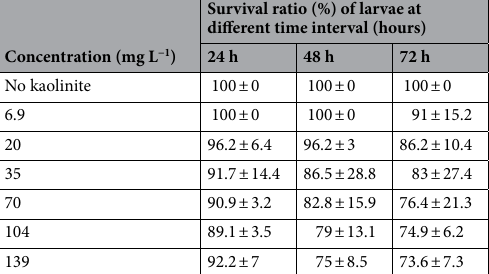
where H r and C are the relative hatching ratio and suspended particle concentration, respectively ( r 2 = 0.99, Fig. 1). Survival of nauplius larvae. Nauplius larvae hatched in filtered seawater were placed in different sus- pended particle concentrations and reared for 72 h. The survival of larvae was examined in all concentrations of suspended particles after 24, 48, and 72 h of exposure. The survival ratio (%) of larvae decreased with expo- sure time along with increasing suspended particle concentration (Table 1). No larval mortality was observed after 24 h in no kaolinite concentration, whereas the survival ratio was 91.7 ± 14.4% and 92.2 ± 7% at 35 mg L −1 and 139 mg L −1 of kaolinite particles, respectively. Increased temporal exposure to the same concentrations yielded increased larval mortality. After 72 h of exposure, the lowest survival ratio was recorded as 73.6 ± 7.3% at 139 mg L −1 . Based on the exponential approximation the relationship between the concentration of suspended particles and relative survival ratio after 72 h of exposure was estimated as: